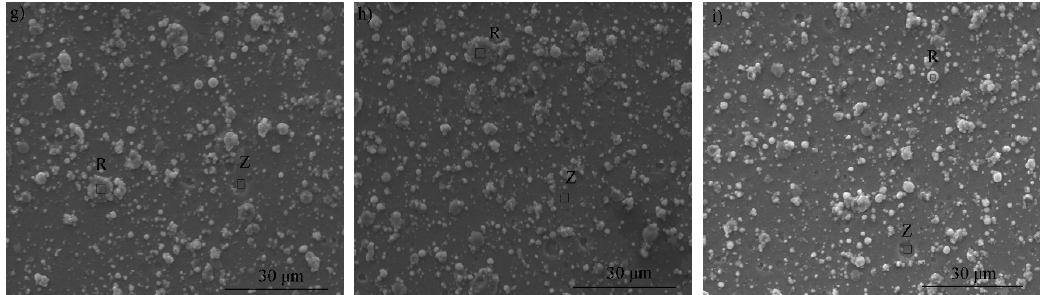
Figure 2. Surface scanning electron microscope (SEM) micrographs of Nos. 1–9 coating specimens: ( a ) No. 1 coating specimen; ( b ) No. 2 coating specimen; ( c ) No. 3 coating specimen; ( d ) No. 4 coating specimen; ( e ) No. 5 coating specimen; ( f ) No. 6 coating specimen; ( g ) No. 7 coating specimen; ( h ) No. 8 coating specimen; ( i ) No. 9 coating specimen.